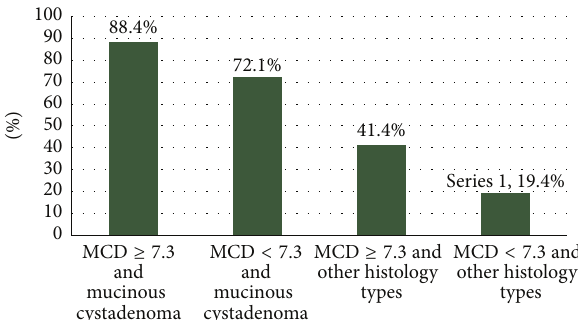
Figure 4: Probabilities of spillage in relation to MCD (cm) and cyst